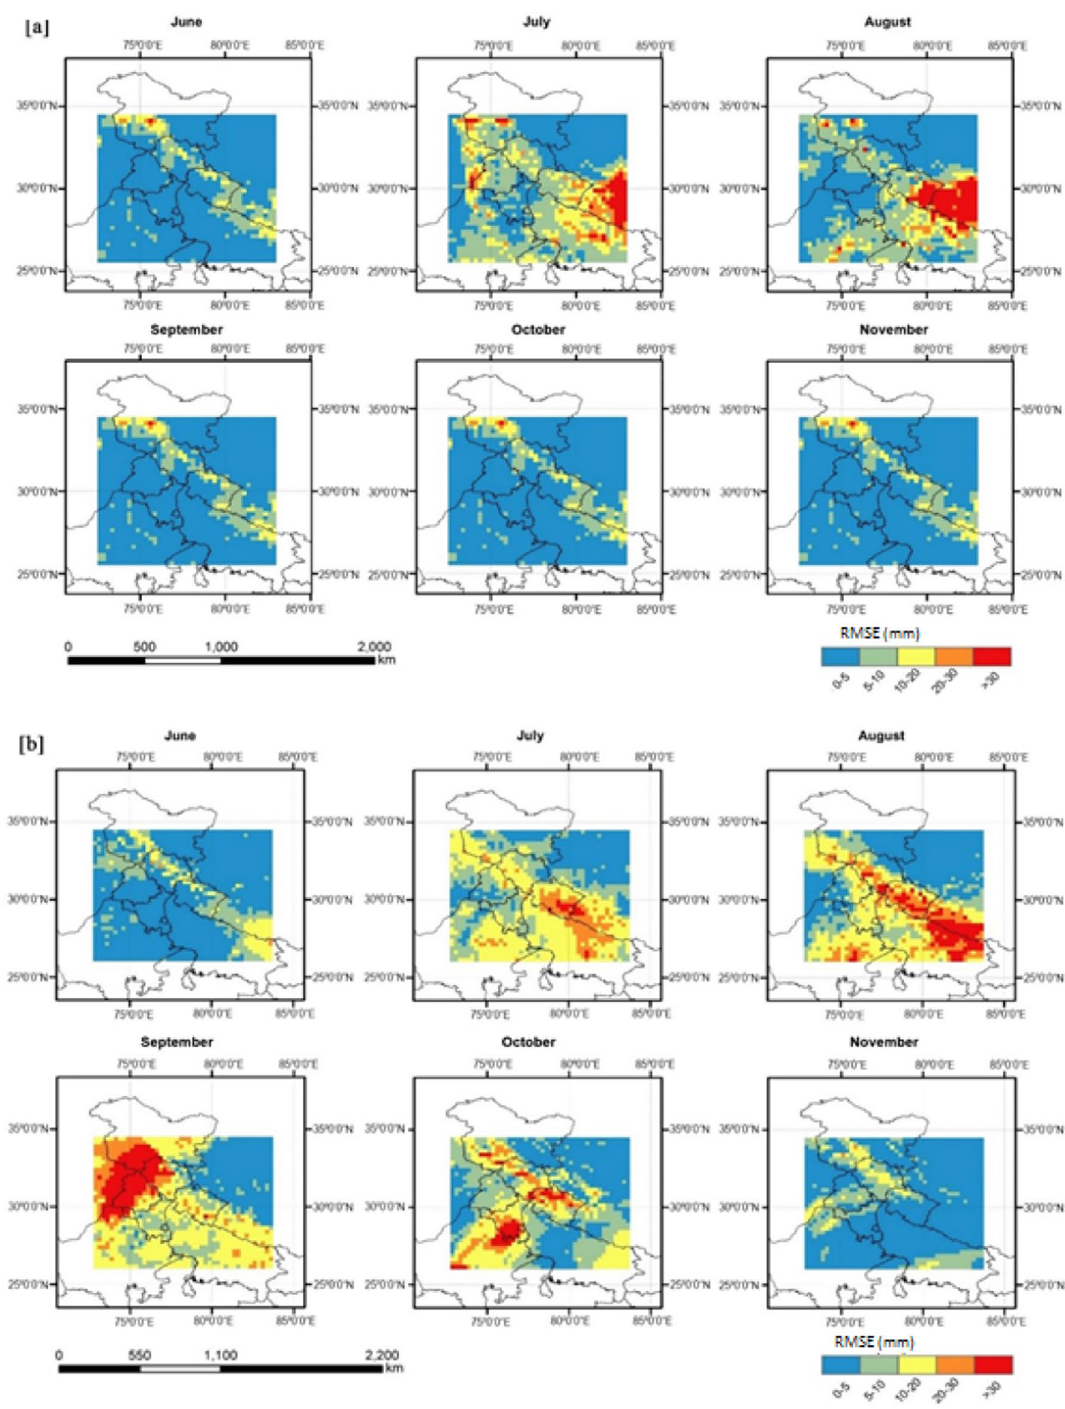
Figure 4. Spatiotemporal validation of WRF monthly rainfall simulations against TRMM based on RMSE (mm) for the months from Jun to Nov during ( a ) 2009; ( b ) 2014 (Map created at IIRS—https:// www. iirs. gov. in/ inhou selab orato